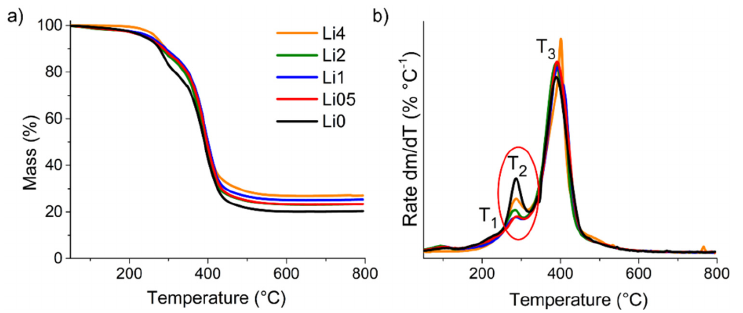
Figure 6. ( a ) TGA and ( b ) dTG (first derivative) of PMMA–silica samples containing different lith- ium concentrations (0–4000